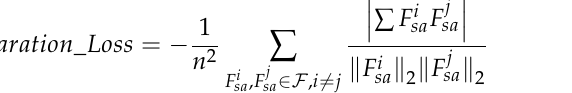
Figure 4. Position code in PC_SortNet.